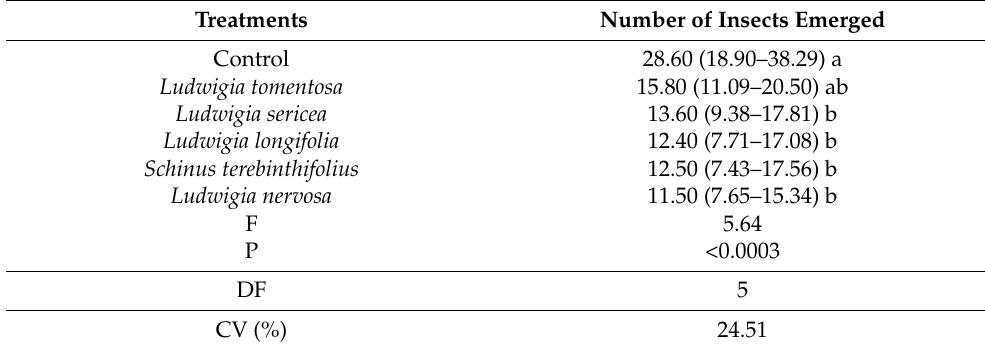
Table 2. Number of insects emerged after 60 days of Sitophilus zeamais infestation (choice test), in thirty grams of maize treated with 10% aqueous extract of five plants and one control (water), Dourados,